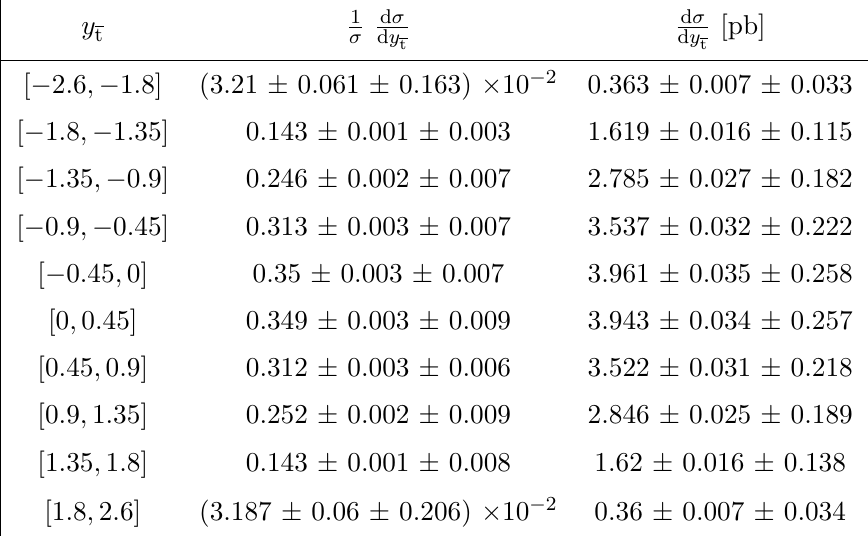
Table 21 . The measured di(cid:11)erential cross section and bin boundaries for each bin of the normalized and absolute measurements of the tt di(cid:11)erential cross section at particle level in the (cid:12)ducial phase space as a function of y are t